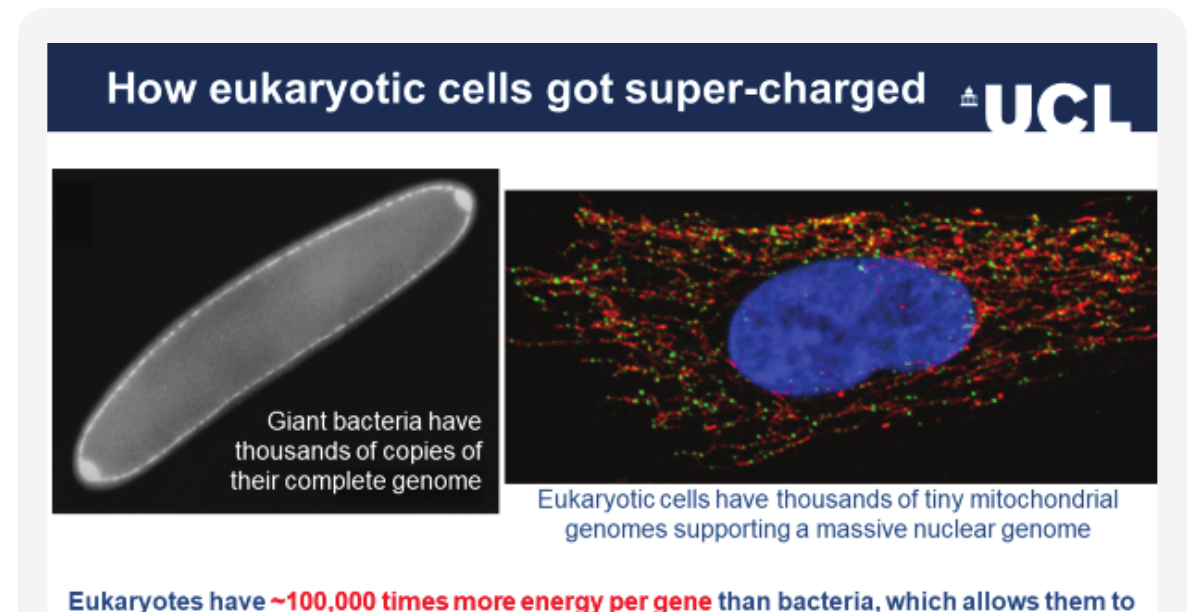
Figure 6. Eukaryotes have more energy per